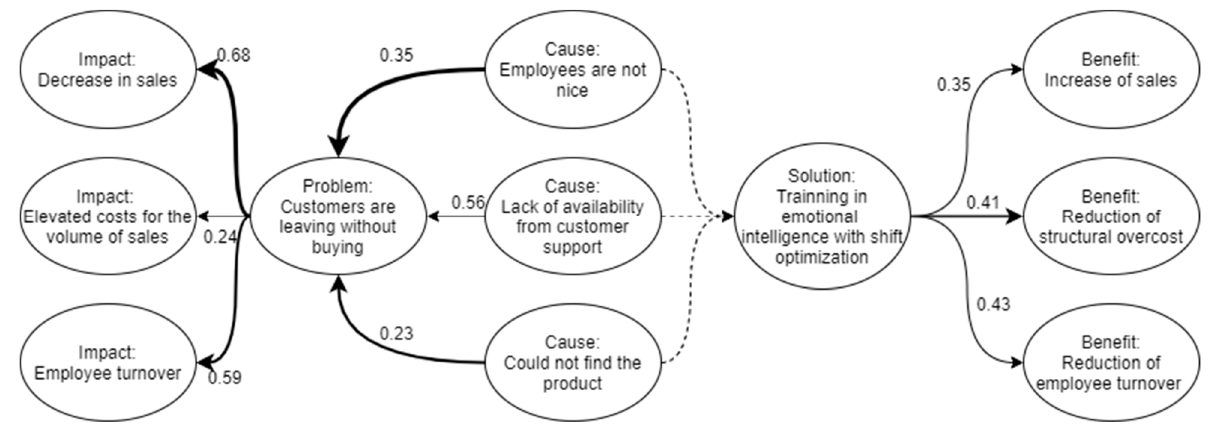
Figure 13. Example of Partial Least Square Path Modeling (PLSPM) results (authors).